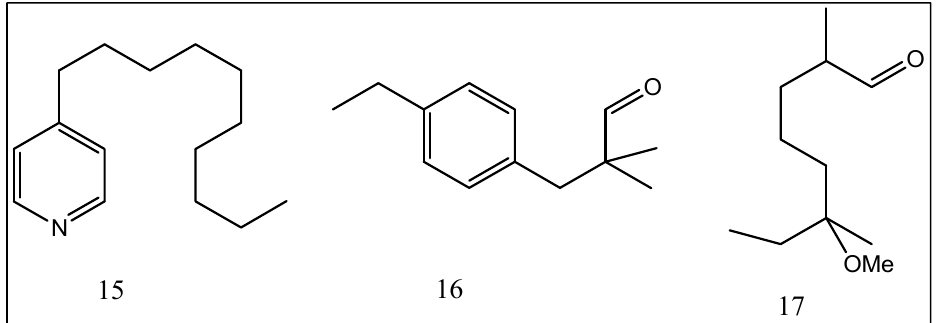
Figure 7. Typical marine odour compounds.